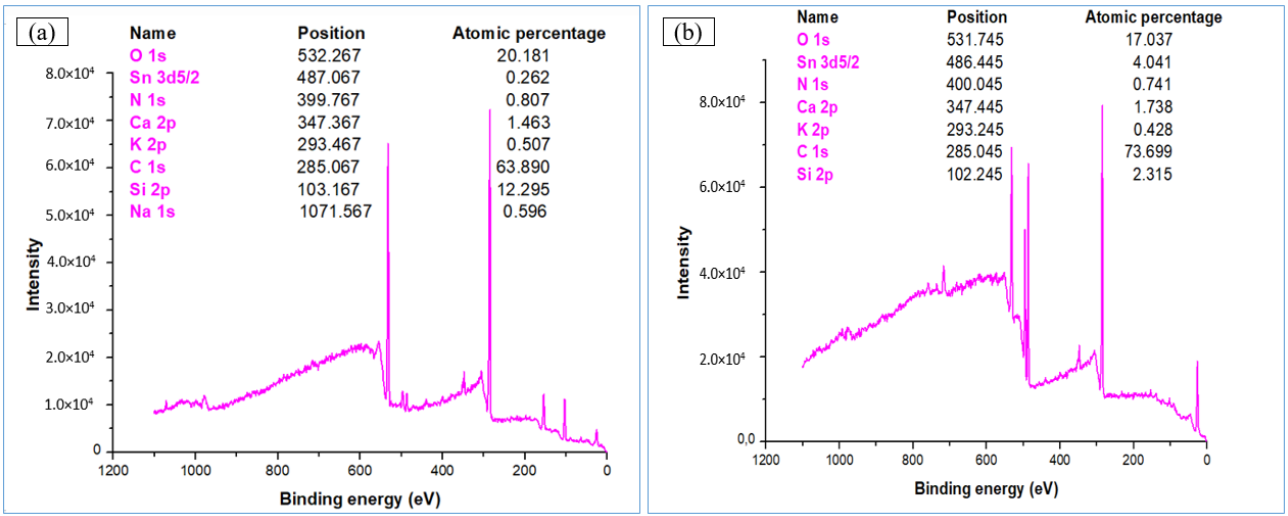
Figure 5. Chemical composition of ( a ) uncoated, and ( b ) coated samples.